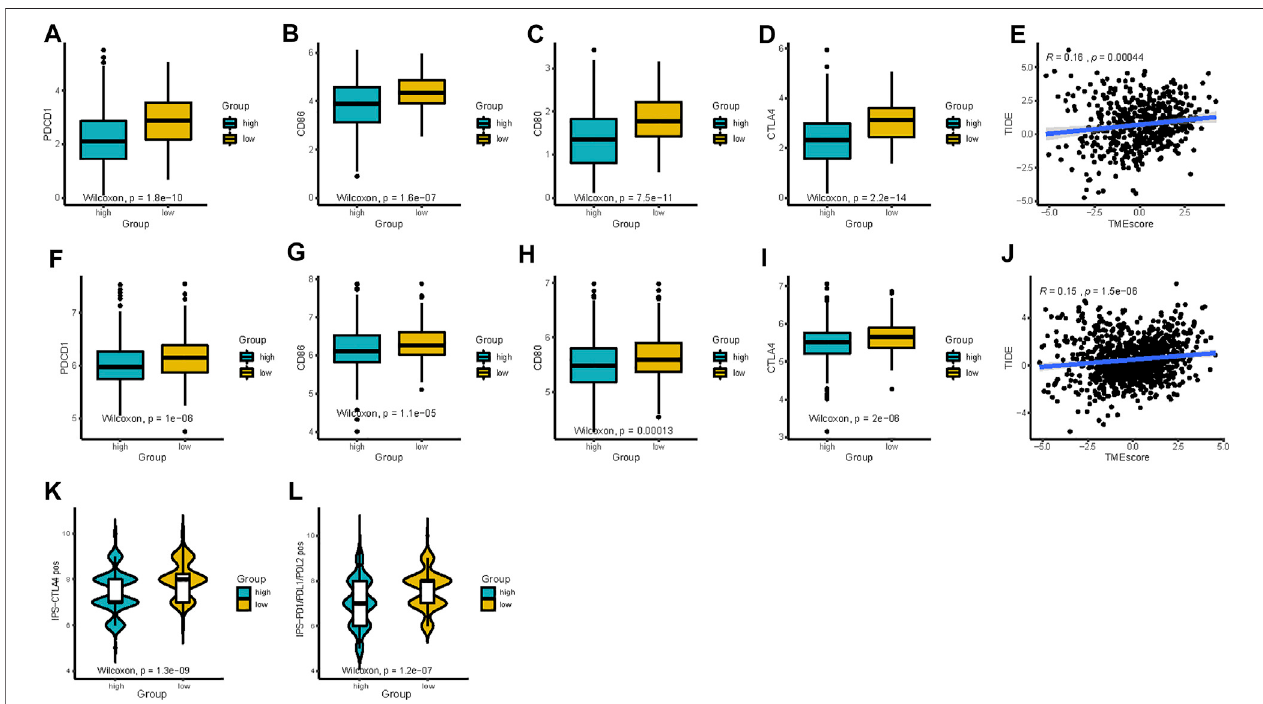
FIGURE 6 | TMEscore in the prediction of immunotherapeutic bene fi ts. (A – D) Expression of immune-checkpoint-relevant genes (PDCD1, CD86, CD80, and CTLA4)betweenhigh-andlow-TMEscoregroupsinTCGAand (F – I) all1,018patientsinGEOdatasetsafterbatchcorrection. (E and J) RelationshipsbetweenTIDEand TMEscoreinTCGAand GEOdatasets. (K and L) Relativeprobabilities ofresponsetoanti-CTLA-4 andanti-PD-1/PD-L1 treatment (IPSscore) inthelow-TMEscoreand high-TMEscore groups in TCGA cohort.